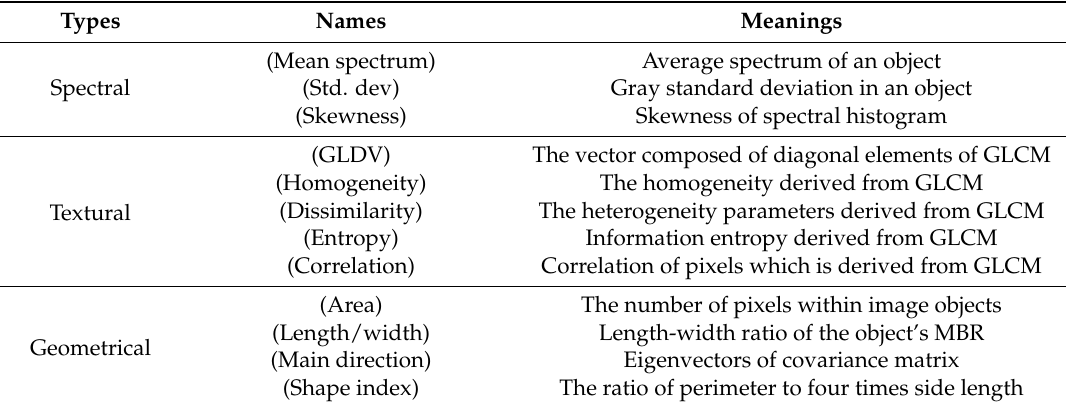
Figure 11. ( a ) The Original WorldView-II image in Beijing; and ( b ) its object classification results. Table 3. Visual features for characterizing